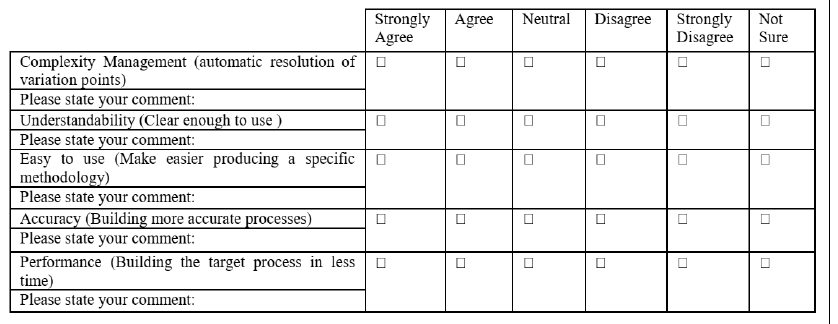
Figure A11. Questionnaire designed for measuring perceived usefulness and ease of use.